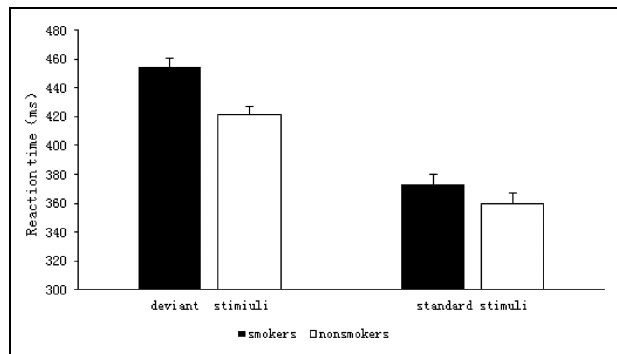
FIGURE 3 | RTs for smokers and non-smokers for standard and deviant